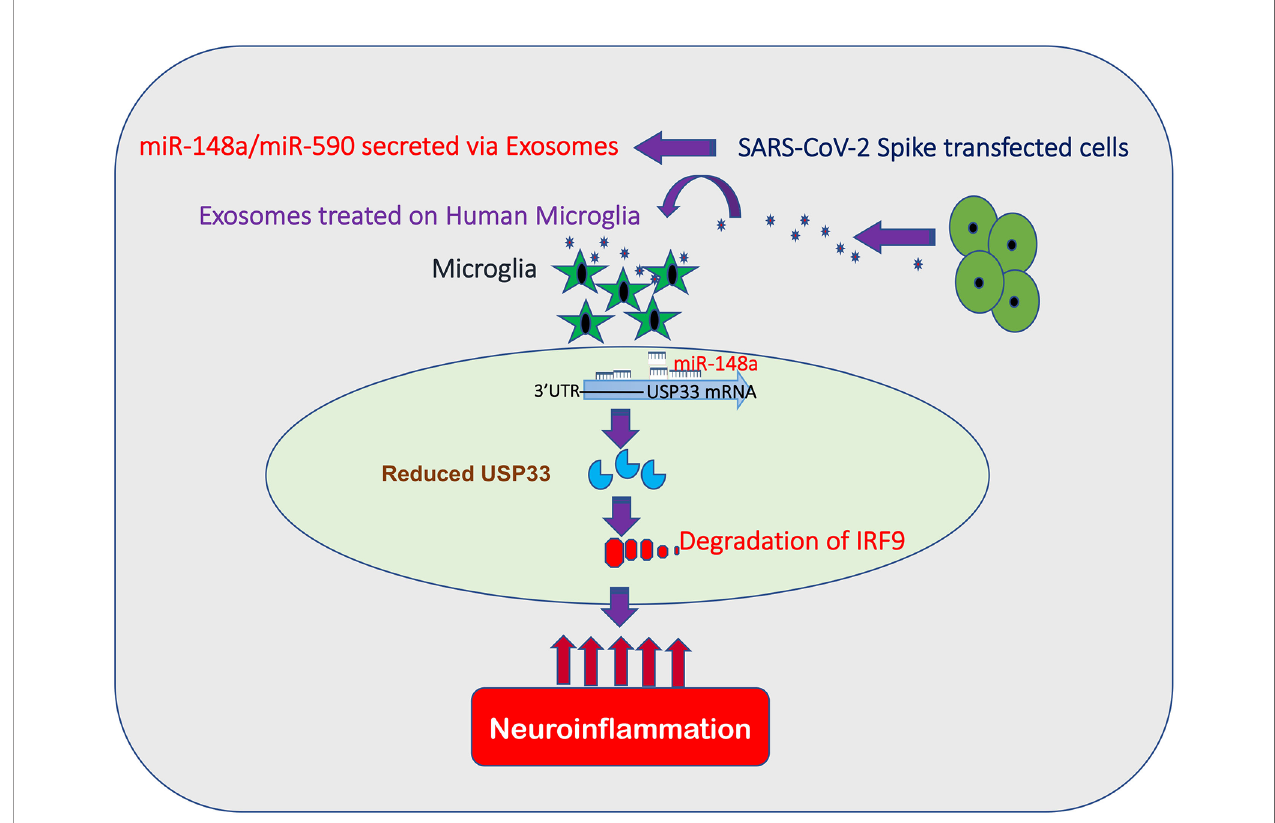
FIGURE 7 | SARS-CoV-2 Spike targets USP33-IRF9 axis via Exosomal miR-148a to activate Human Microglia. Schematic fl ow diagram representing the mechanistic route utilized by SARS-CoV-2 Spike protein to target USP33-IRF9 axis via modulating exosomal miR-148a to activate the human microglial